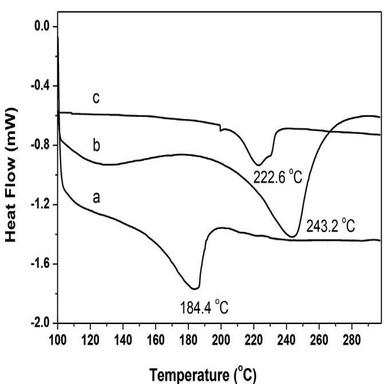
DSC curves of the P3HT-MWCNT prepared by click chemistry: (a) P3HT; (b) P3HT-MWCNT; (c) physical blend of P3HT and 80 wt% MWCNT.